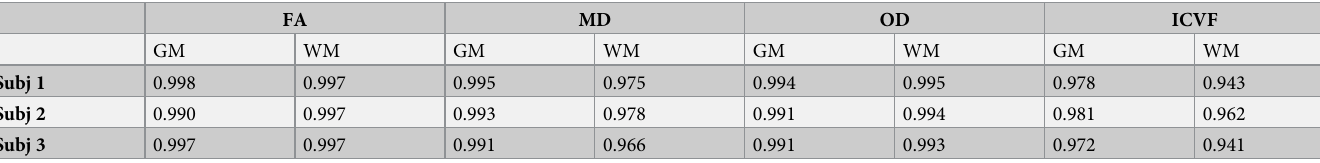
Table 3. SENSE1-dSoS correlations of diffusion metrics (FA, MD, OD, and ICVF). For the dSoS data used in this table, the model was trained on data that was merged from the other two subjects. The dSoS data for SUBJ 1, for example, was obtained by applying a model trained on the combined data of SUBJ 2 and SUBJ 3 to SUBJ 1’s SoS